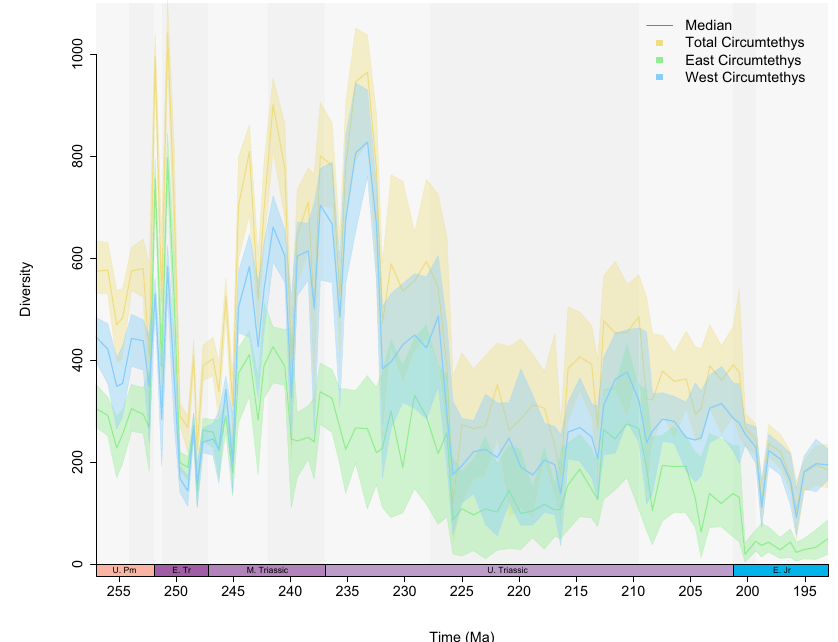
Fig. 6 Probabilistic median diversity and 50%, 75% and 95% highest posterior densities. Diversity trajectories derived from the total Circumtethys region and its eastern and western subdomains, highlighting the dissonance in trends between regions and at different spatial scales. Diversity dynamics at broader spatial scales are therefore not simply the result of upscaling of regional processes. The greater degree of congruence between the total Circumtethyan dataset and its larger subcomponent (West Circumtethys) additionally demonstrates how oversampling of one particular region may end up driving the global trend. Displayed results are derived from MST-standardised datasets. Source data are provided as a Source Data fi